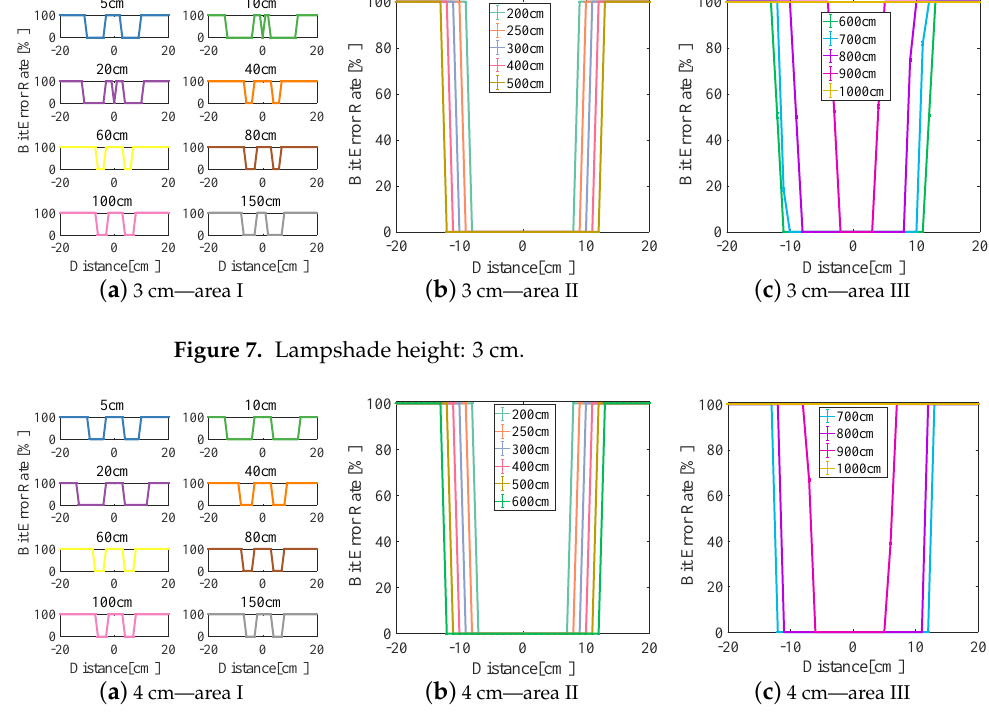
Figure 8. Lampshade height: 4